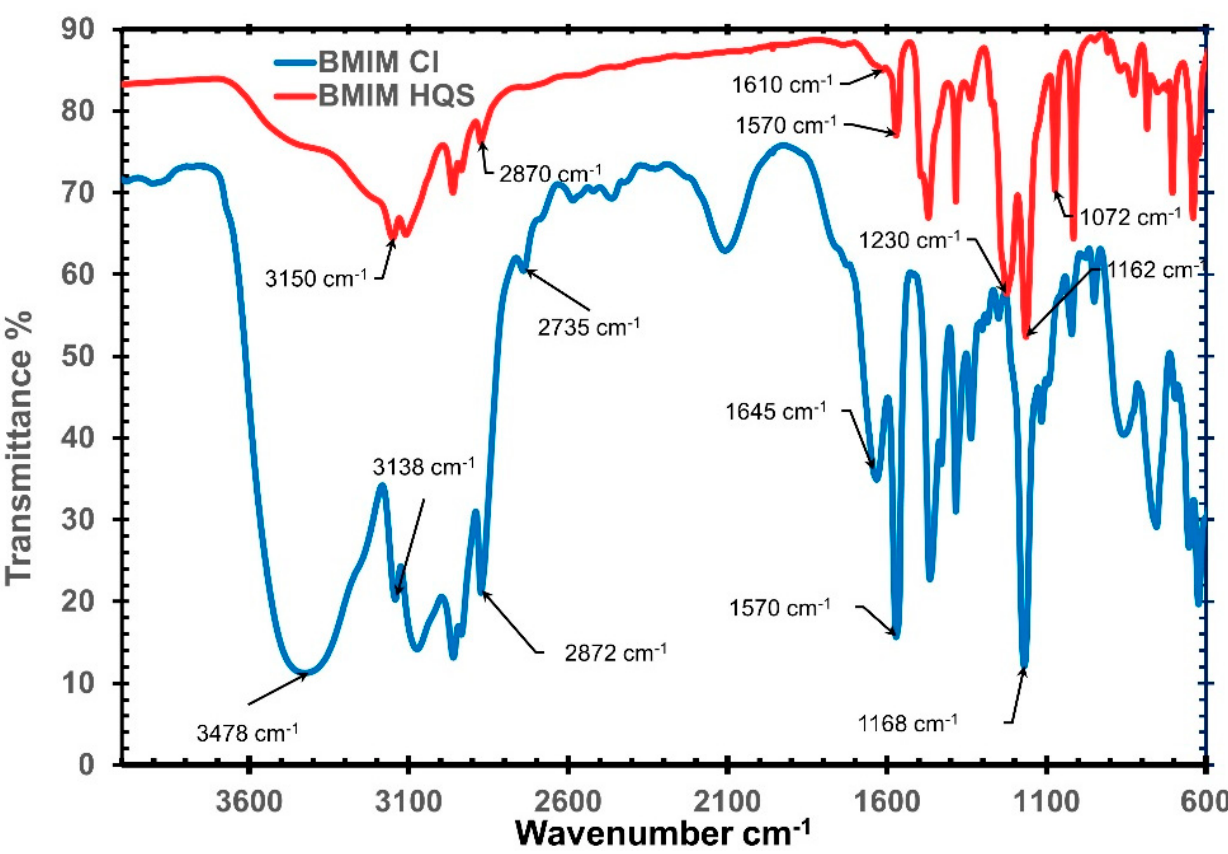
Figure 2. Infrared spectra for [BMIM][Cl] and [BMIM][HQS].